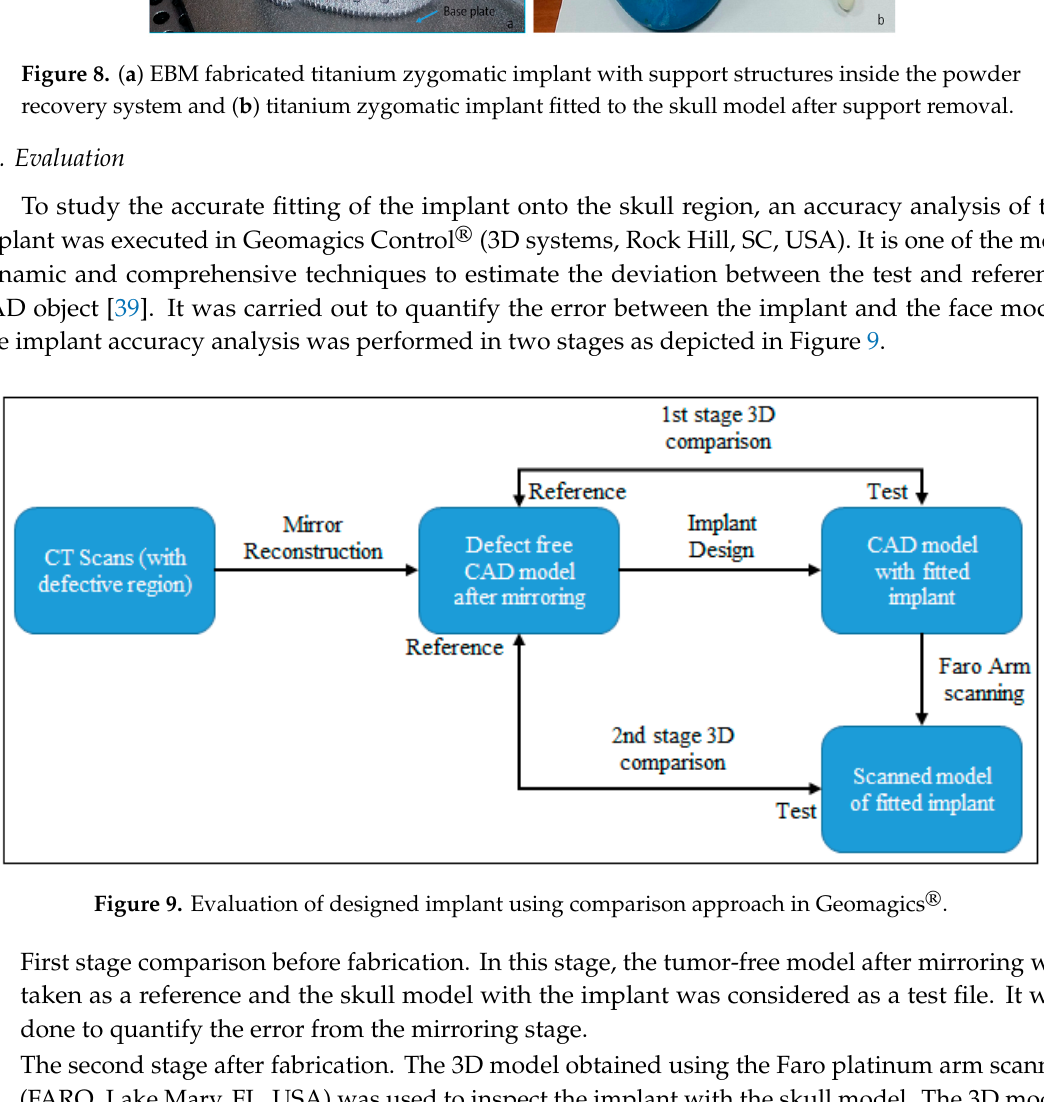
Figure 9. Evaluation of designed implant using comparison approach in Geomagics ® .